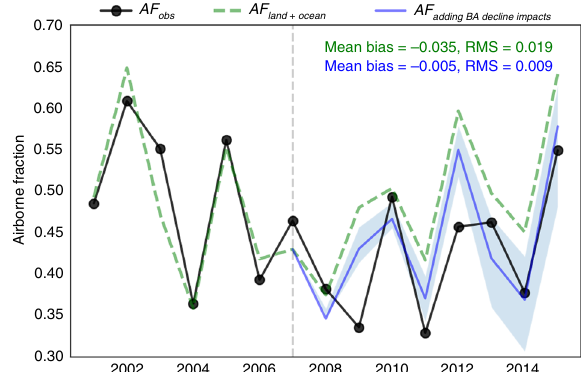
Fig. 6 Estimated impacts of fi re decline on airborne fraction. The impacts of fi re decline between 2008 – 2014 and 2001 – 2007 are evaluated here. Emissions from Fossil fuel ( E FF ) and from land use change (E LUC ), atmospheric CO 2 growth rate ( G ATM ), and process-based sink estimates for ocean (S OCEAN ) and land (S LAND ) are derived from GCP 2018 estimates to determine the airborne fraction (each component shown in Supplementary Fig. 10. AF obs = G ATM /( E FF + E LUC ), showing the observed G ATM relative to the total emissions from E FF and E LUC ; AF land + ocean = 1 − ( S OCEAN + S LAND )/ ( E FF + E LUC ), representing the portion of AF variations that can be explained by current process-based estimates of land and ocean sinks; AF + BA Decline = 1 − ( S + S − Δ FIRE − Δ NEE)/( E + E OCEAN LAND FF LUC ), representing the adjusted AF by adding for our estimates of BA decline impacts relative to the mean 2001 – 2007 BA. Note that the adaptations to 2015 are only due to the legacy effect of the period 2008 –